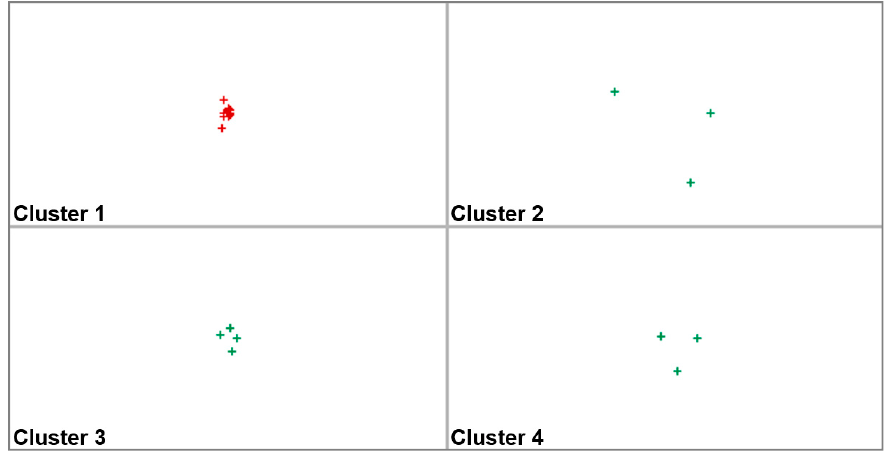
Figure 6. Topological map for individual similar groups of the EU countries (own elaboration).